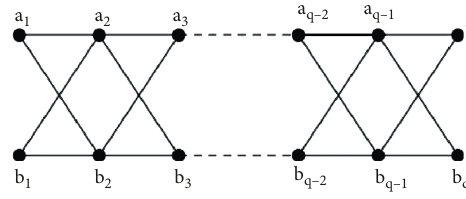
Figure 3: Double path network [ P 2 Table 5: The possible resolving neighbourhood sets of P 2